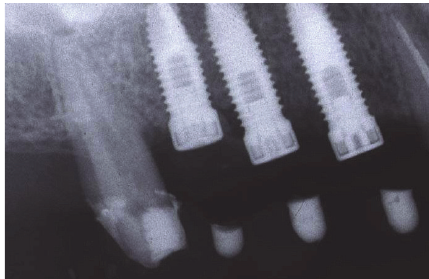
Figure 18: An odontoplasty mesial to tooth 17 was then performed to allocate implant 16 in a prosthetically proper position.